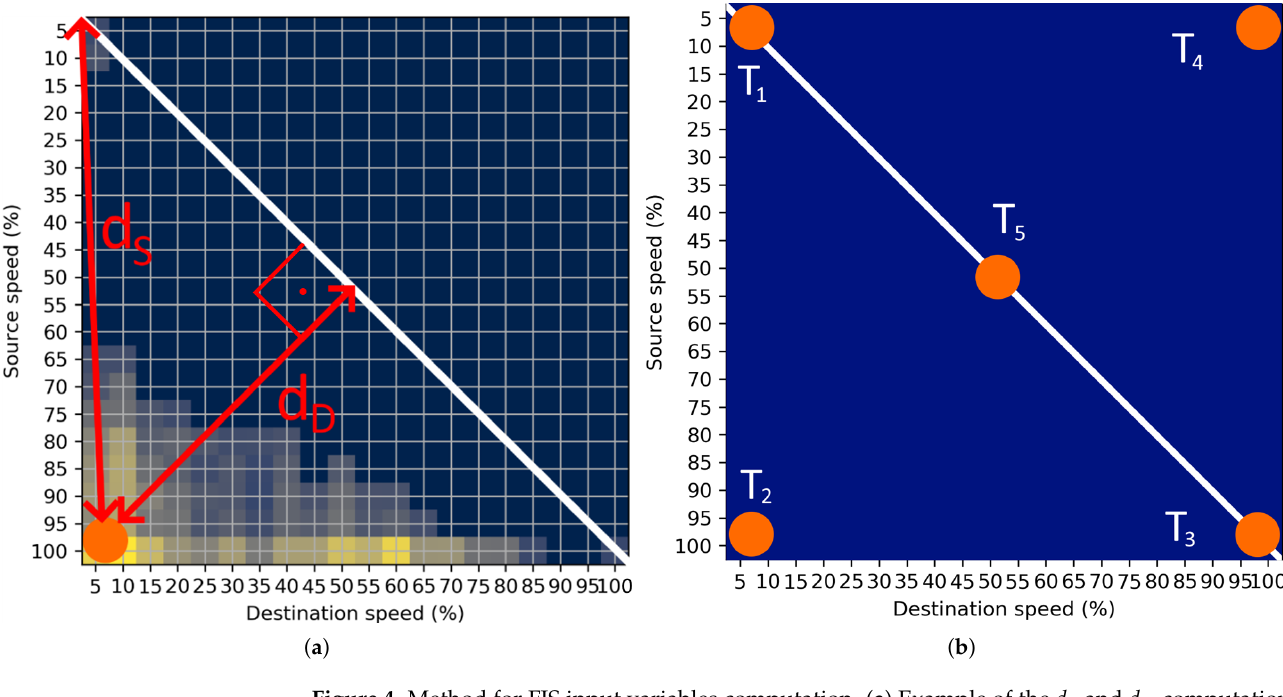
Figure 4. Method for FIS input variables computation. ( a ) Example of the d S and d D computation; ( b ) CoM positions of characteristic